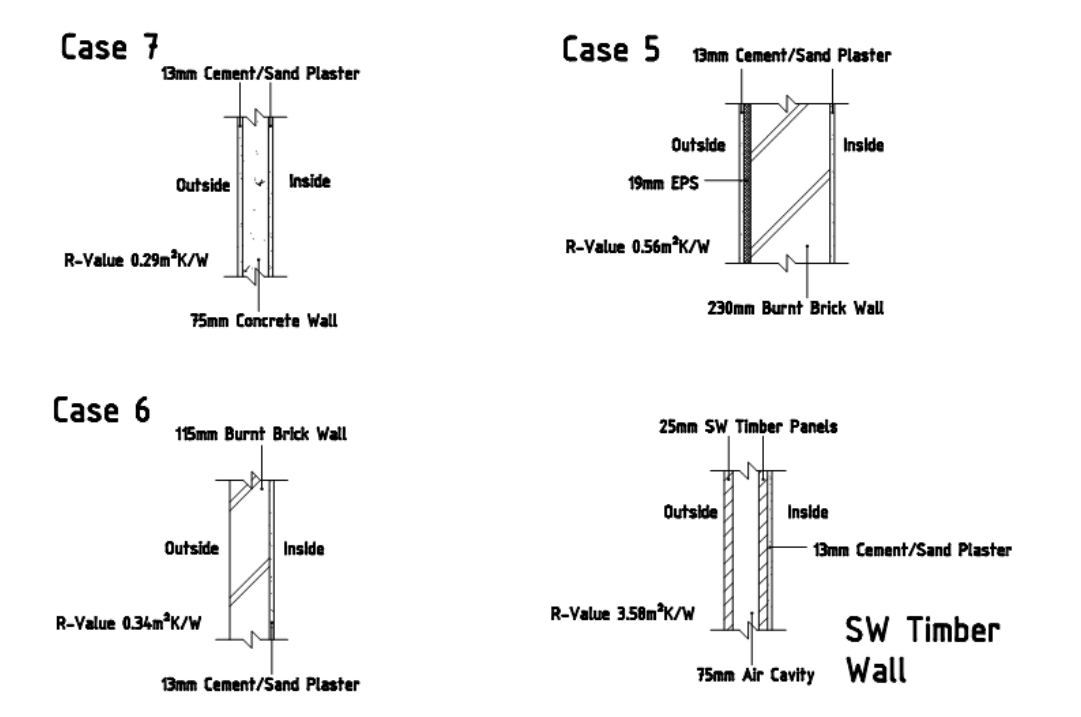
Figure A3. Wall envelope configuration.